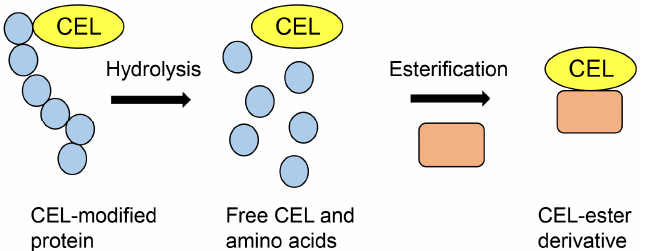
Figure 6. Model image of preparation of CEL-ester derivative for GC–MS analysis. Closed blue circles are amino acids. Closed peach squares are the compounds which have hydroxyl groups.